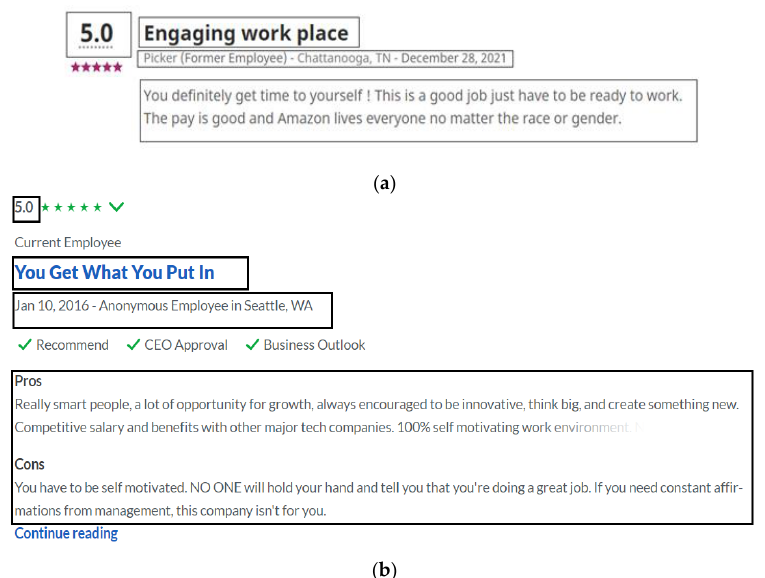
Table 1. Metadata table.